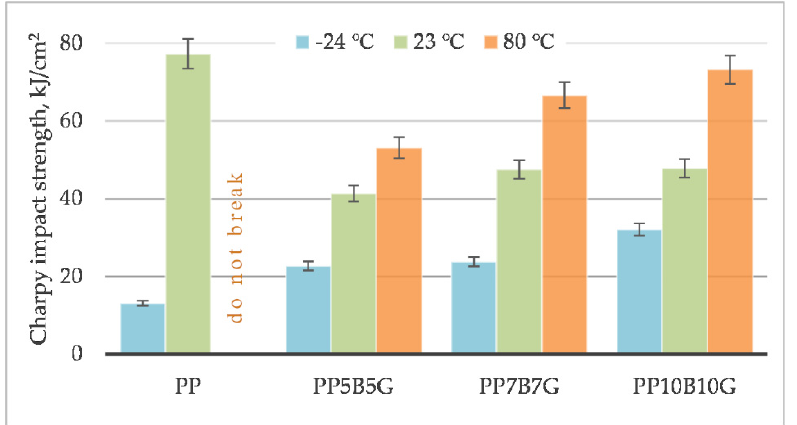
Figure 12. Unnotched Charpy impact strength of basalt/glass polypropylene composites at − 24 °C, 23 °C and 80 °C.